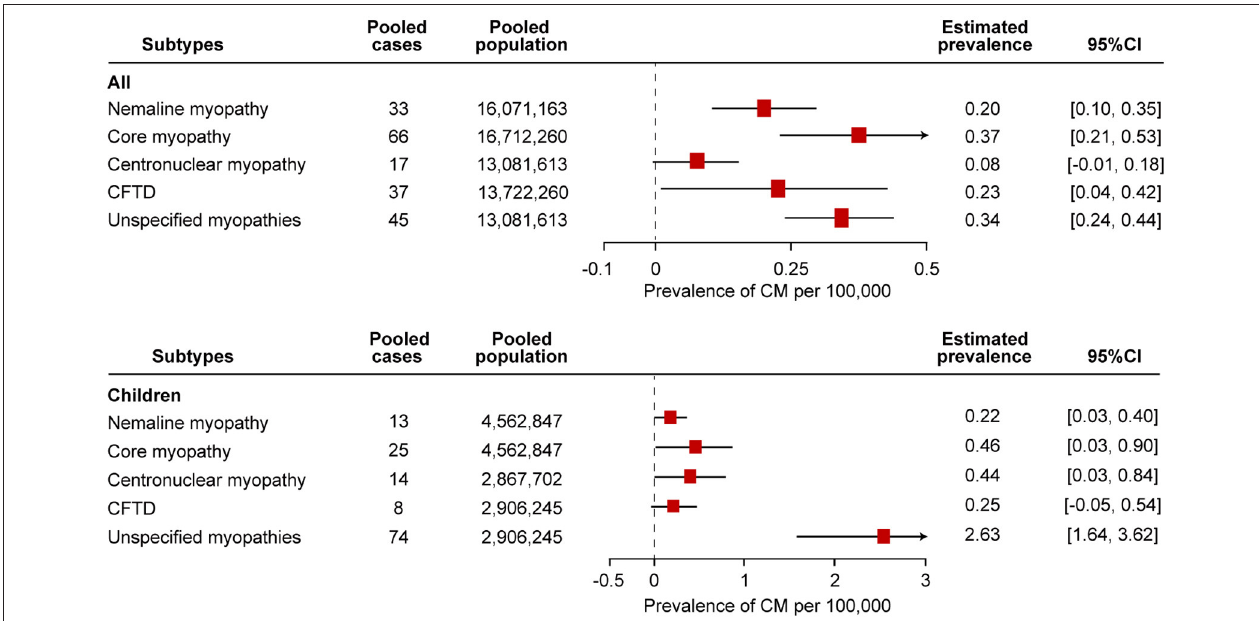
FIGURE 4 | Comparison of the estimated prevalence of different subtypes of congenital myopathy per 100,000 cases along with the 95% confidence interval (CI). CFTD, congenital fiber-type disproportion myopathy.